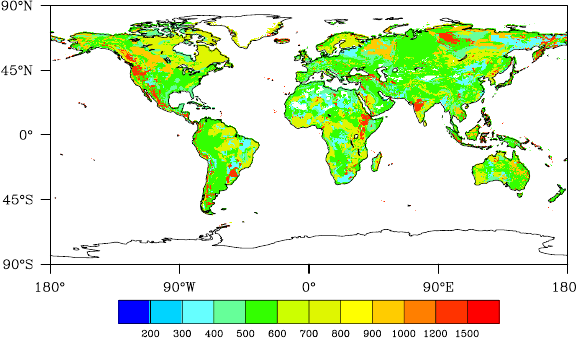
Fig. 2. The distribution of P concentration in soil parent material (unit: ppm)